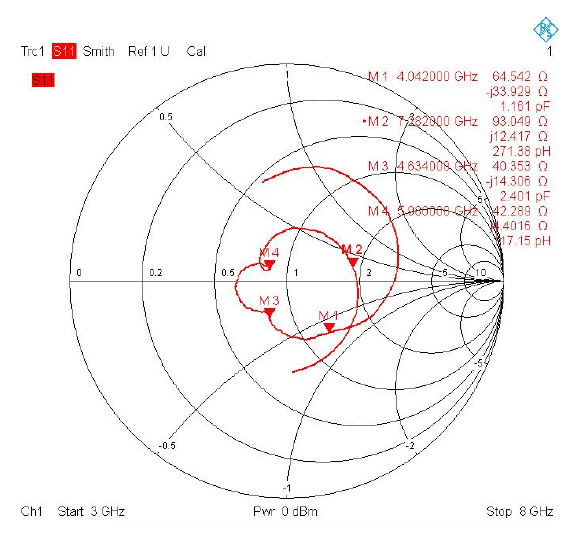
Figure 11. Measured input impedance of proposed geometry